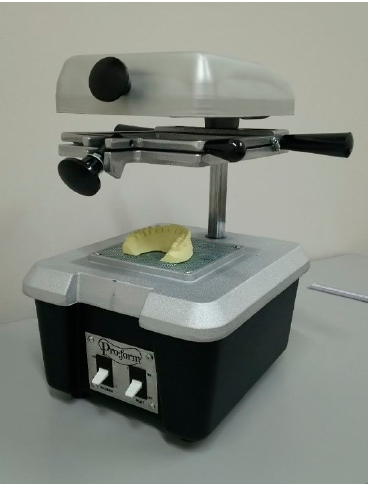
Figure 10. Typical vacuum forming machine (adapted) [54]. Copyright Wiley-VCH Verlag GmbH & Co. KGaA. Reproduced with permission.